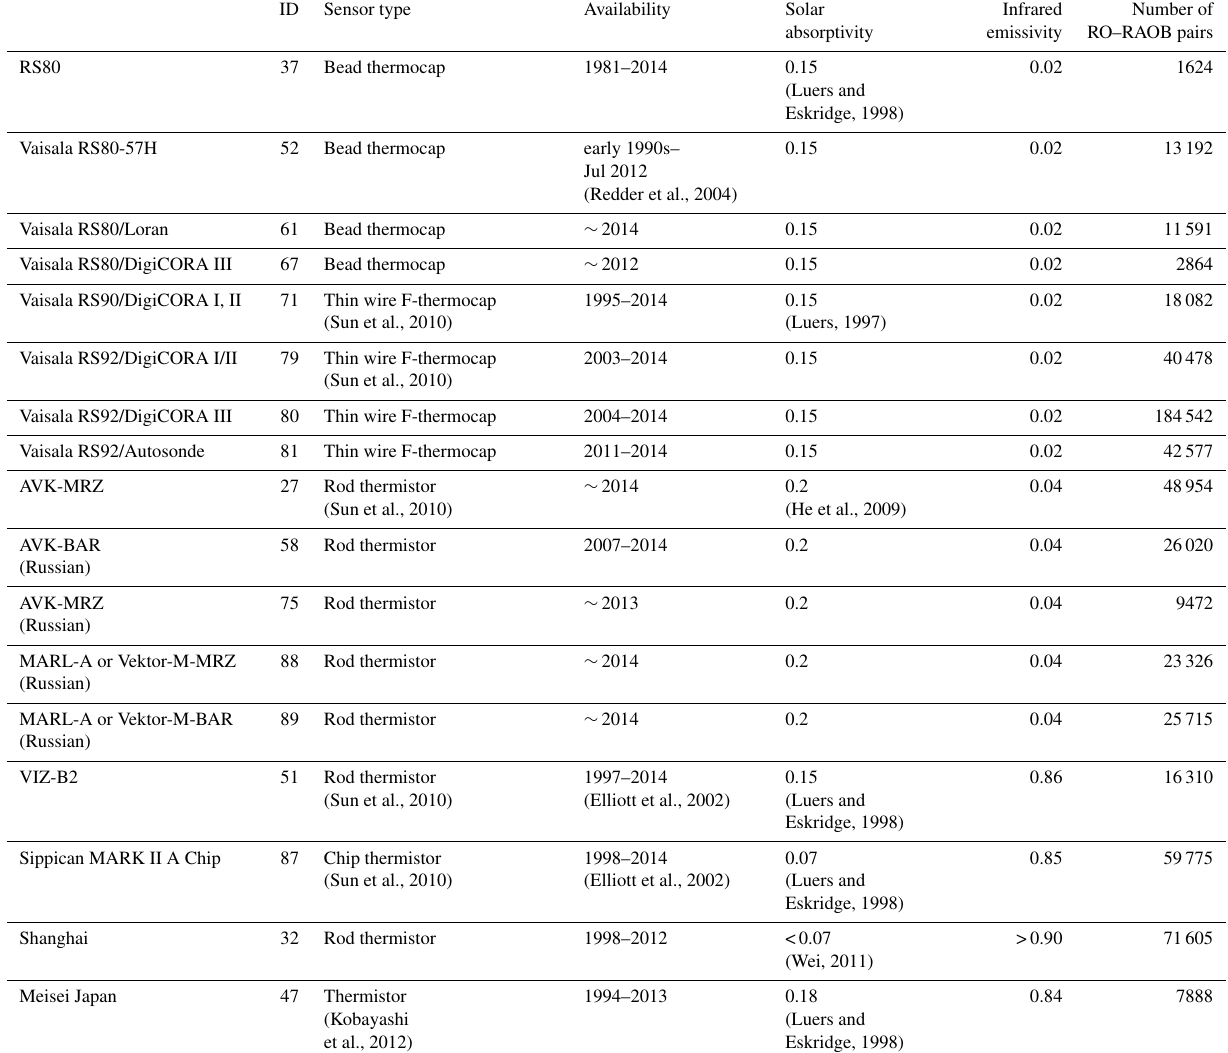
Table 1. Summary of the availability for different instrument types and their solar absorptivity ( α) and sensor infrared emissivity ( ε ) for the corresponding thermocap and thermistor and the sample number of RAOB–RO pairs used in this study from June 2006 to April